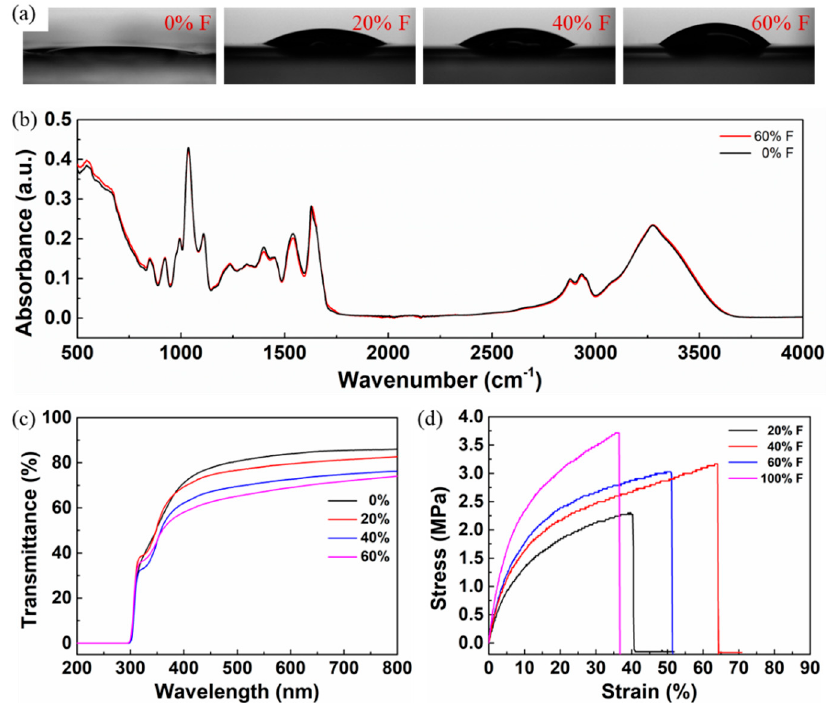
Figure 3. ( a ) Contact angle, ( b ) FTIR spectrum, ( c ) transmittance spectrum, and ( d ) tensile measure- ments of WPI films with different concentrations of formaldehyde.